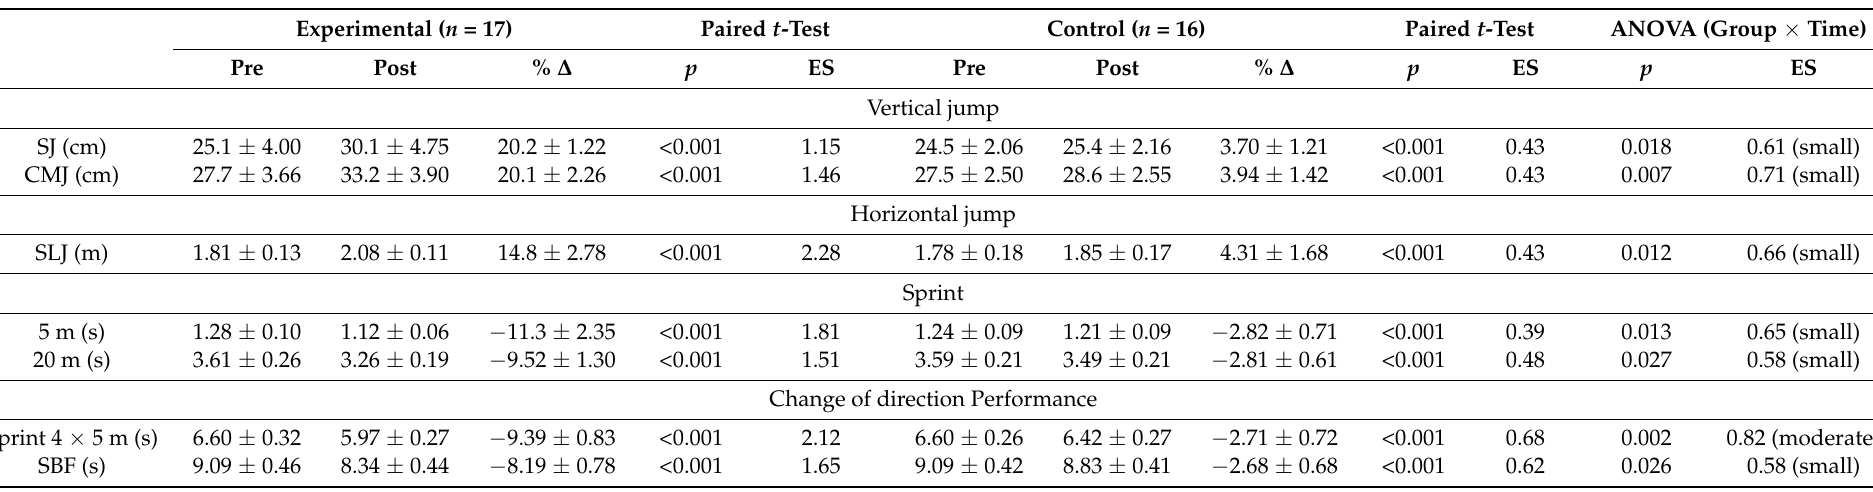
Table 4. Vertical and horizontal jump tests, sprint times, and change-of-direction performance performances in experimental and control groups before and after the 8-week intervention. Experimental ( n = 17) Paired t -Test Control ( n = 16) Paired t -Test ANOVA (Group × Time) Pre Post % ∆ p ES Pre Post % ∆ p ES p ES Vertical jump